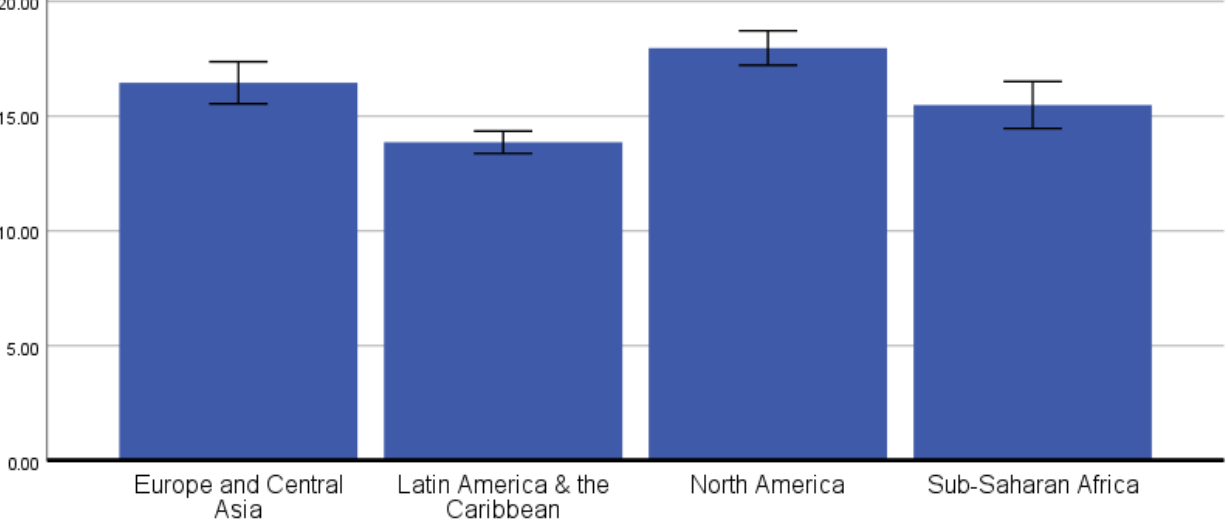
Figure 3. Covariate-adjusted affective symptom severity scores (mean with 95% confidence interval) by global region. Note : A graphic that shows the differences in affective symptoms by Global Region. The participants from Latin America and the Caribbean reported significantly lower affective symptom severity than participants from Europe and Central Asia, North America, and Sub-Saharan Africa. Participants from Sub-Saharan Africa also reported lower affective symptom severity than those from North America.